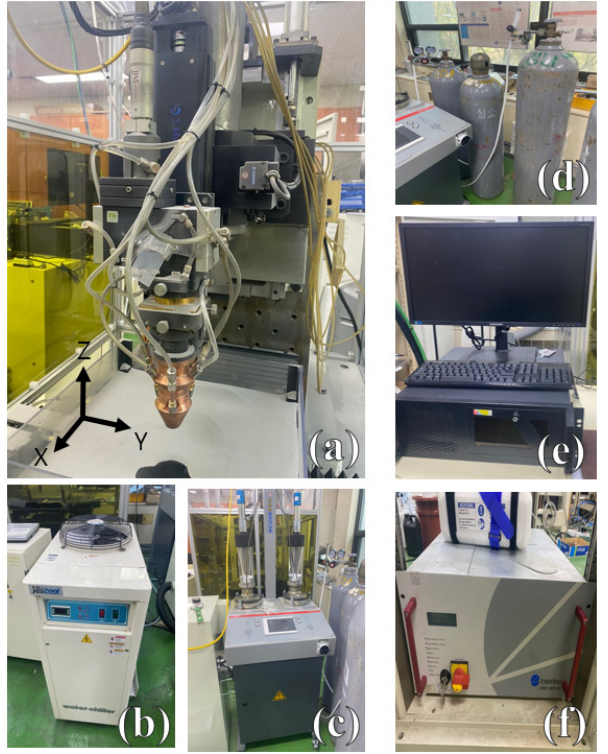
Figure 3. Experimental setup: ( a ) AM system; ( b ) water chiller; ( c ) powder feeder; ( d ) argon gas and nitrogen gas; ( e ) control computer; and ( f ) 2 kW diode laser.